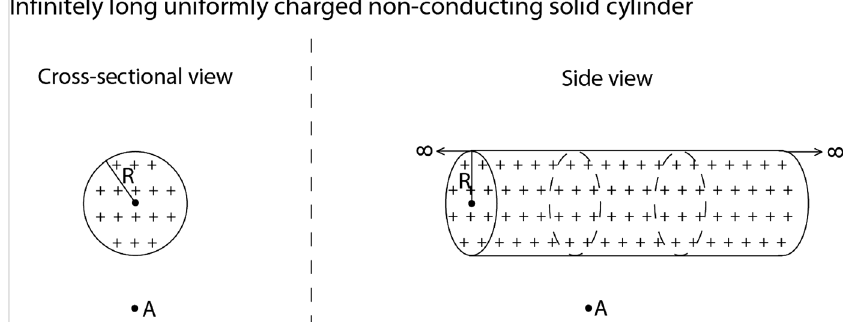
FIG. 6. A schematic diagram for the pretest question (3).